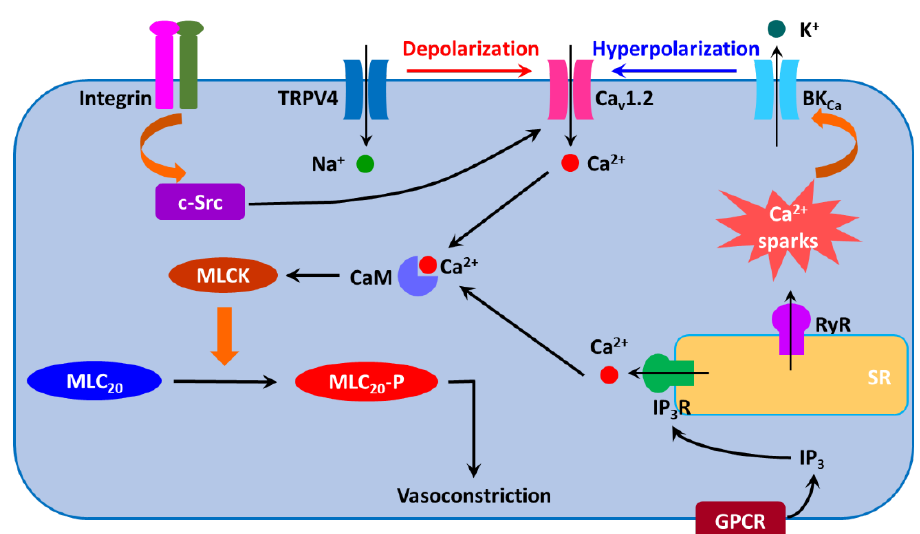
Figure 2. Proposed mechanisms for regulating myogenic tone in small arteries and arterioles. Detailed information is discussed in the text. GPCR, G protein-coupled receptor, TRPV4, Transient receptor potential vanilloid-type 4; BK Ca , large-conductance Ca 2+ -activated K + channel; SR, sarcoplasmic reticulum; IP 3 , inositol triphosphate; RyR, ryanodine receptor; CaM, calmodulin; MLCK, myosin light-chain kinase; MLC 20 , 20 kD myosin light-chain.